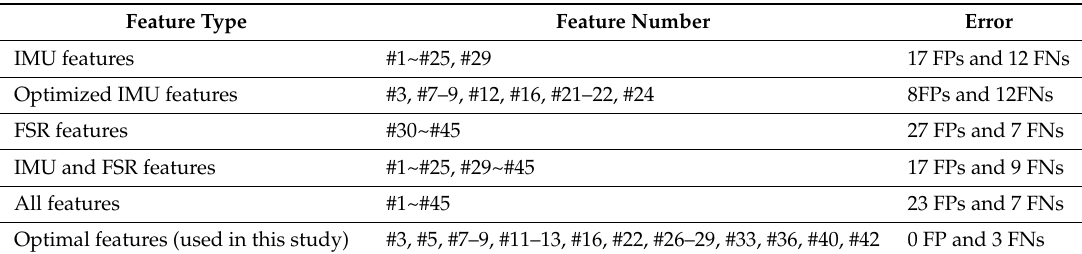
Table 3. Comparison of errors based on feature